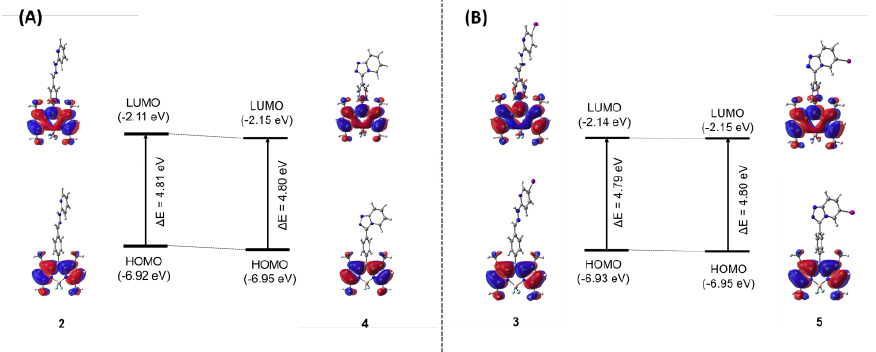
Figure 7. Frontier molecular orbitals (HOMO and LUMO) of compounds 2 and 4 (A), and compounds 3 and 5 (B) and their energy gaps (ΔE in eV) computed by M062X/6-311G* level of theory. The HOMO and LUMO orbitals are plotted with isovalue of 0.02.